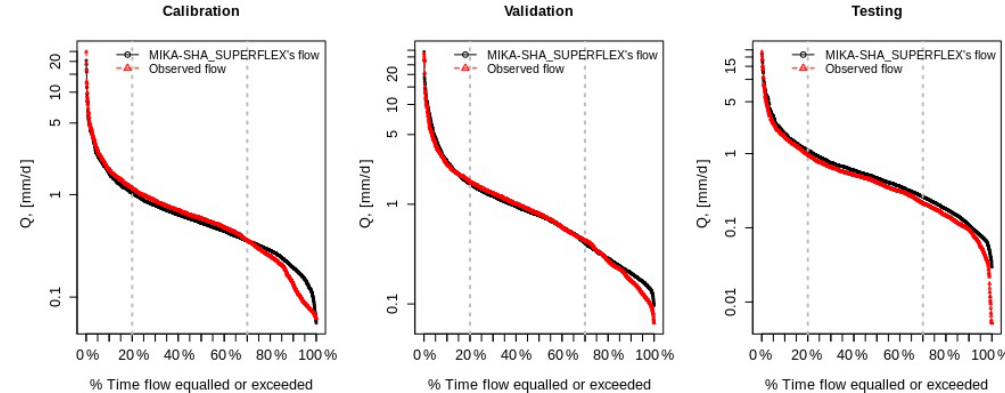
Figure 7. Simulated FDCs of MIKA-SHA_SUPERFLEX with the observed FDCs of the basin.